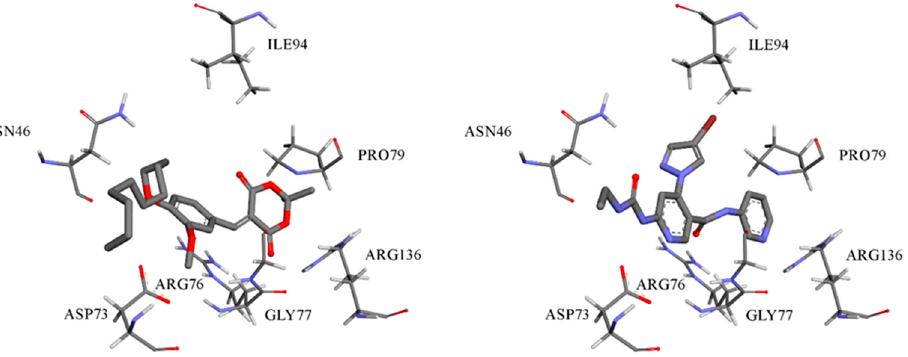
Figure 3. The lowest energy structures that resulted from docking of 3i to active site of Gyrase B of E. coli. ( Left ): 3i , ( right ): P3C.